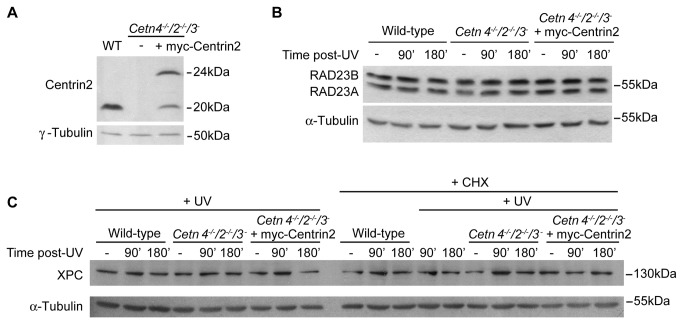
Centrin deficiency does not impact on protein levels of the XPC-RAD23 complex.
A. Immunoblot shows the expression level of centrin2 in cells of the indicated genotype. Two bands are seen in the myc-centrin2 rescue clone due to a second methionine in the centrin2 transgene coding sequence serving as a second potential start site.Immunoblots show the levels of B. RAD23A and RAD23B; C. XPC before and at the indicated times after 20J/m2 UV irradiation in wild-type, centrin-deficient and rescued DT40 cells. The rescue clone was that used in Figure 1B. Where indicated, cycloheximide (CHX) was added at 100µg/ml at time 0. Results shown are representative of 3 experiments. α- and γ-Tubulin were used as loading controls. Size markers are indicated at right.